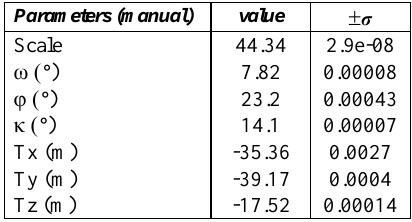
Table 2. Transformation parameters –Manual selection of corresponding points